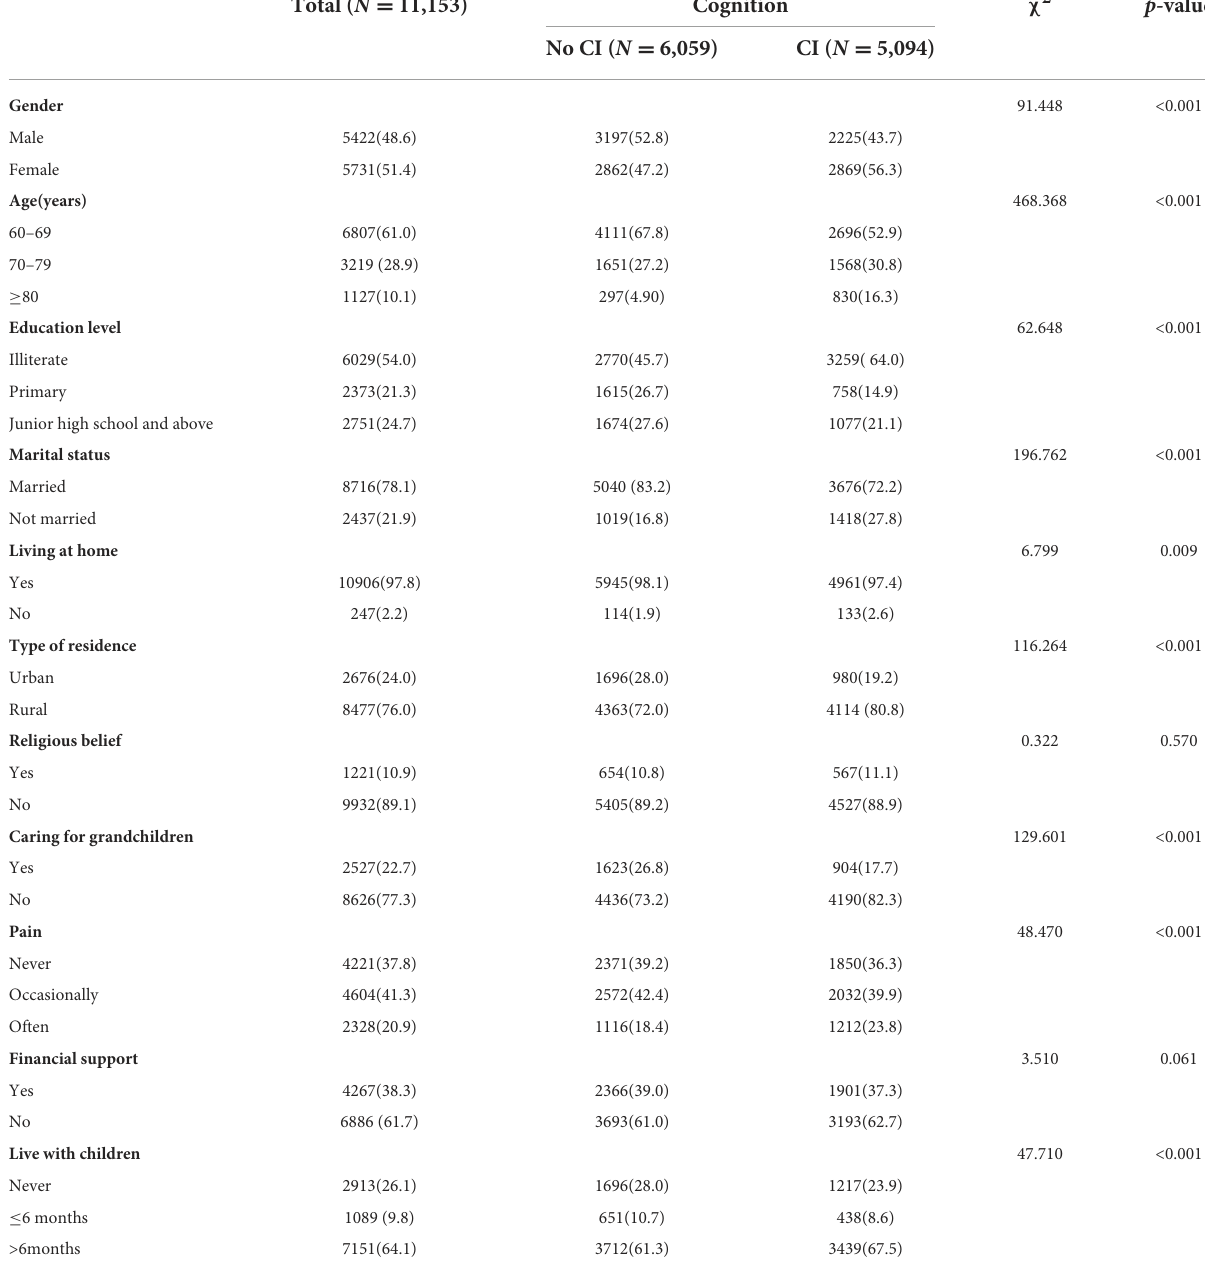
TABLE 1 Single-factor analysis of cognitive impairment among elderly Chinese individuals with different